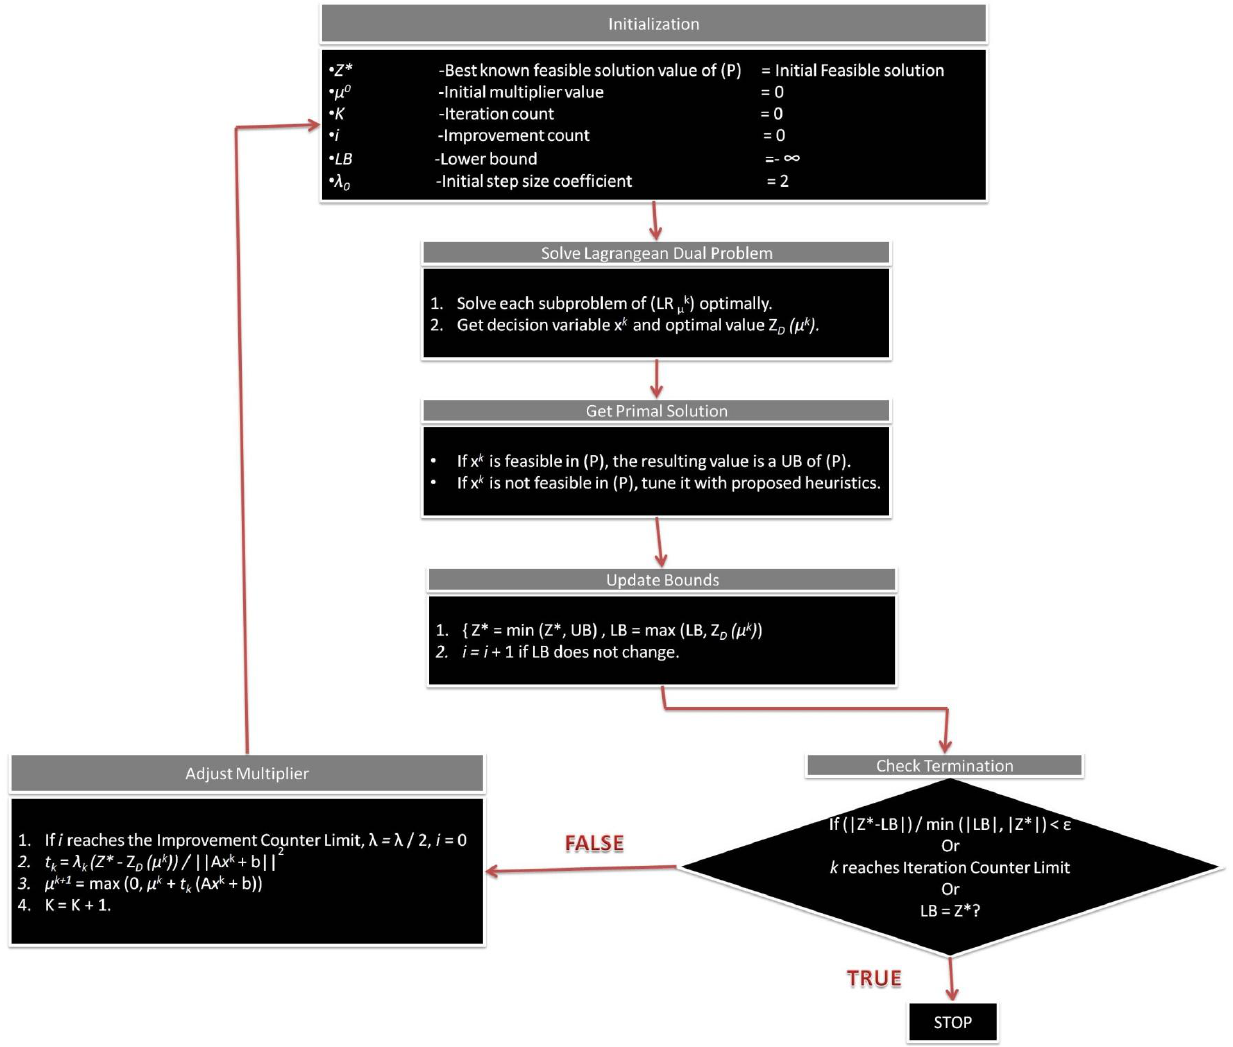
Figure 8. Procedures of Lagrangean Relaxation